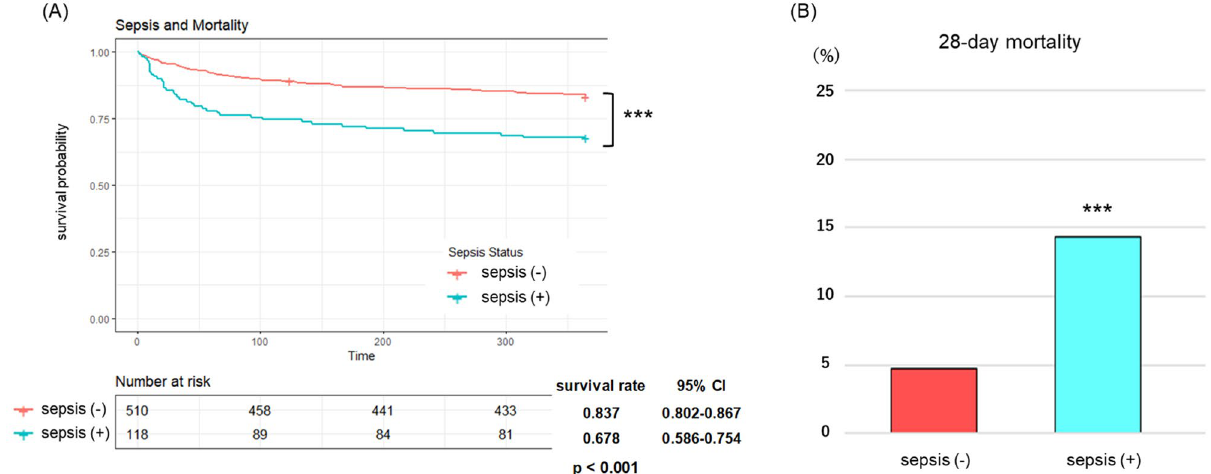
Figure 1. ( A ) Kaplan–Meier survival curve over 365 days by comparing two groups based on whether they had current sepsis or not. Log-rank statistic was performed to assess significance of difference in 365-day mortality. ( B ) 28-day mortality by comparing two groups based on whether they had current sepsis or not. Chi-square test was performed to assess significance of difference in 28-day mortality between the two groups. *** p < 0.001, sepsis (−): sepsis-negative, sepsis (+): sepsis-positive.